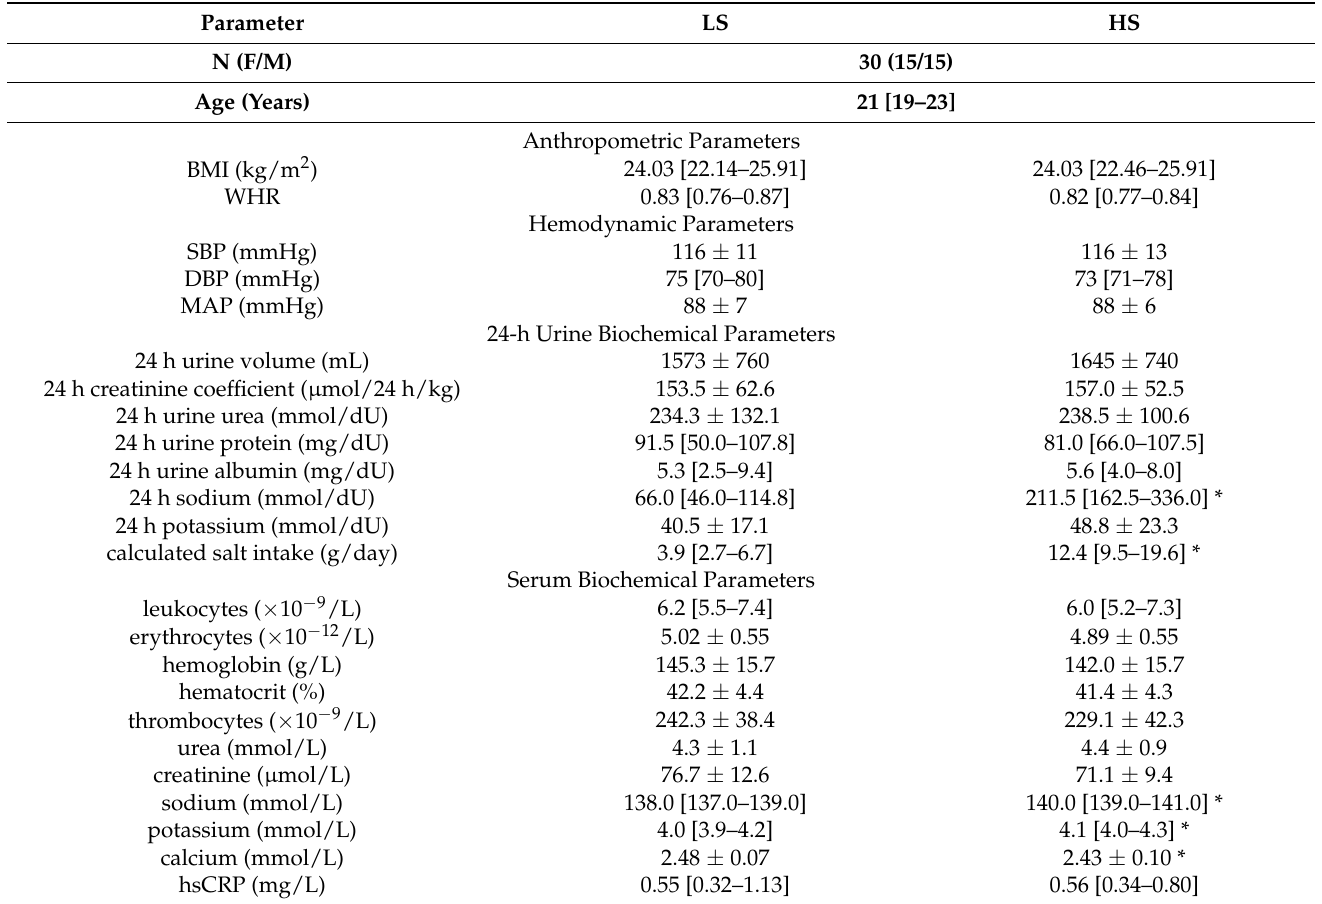
Table 1. Anthropometric, hemodynamic, and biochemical responses to a 7-Day high-salt diet in young healthy